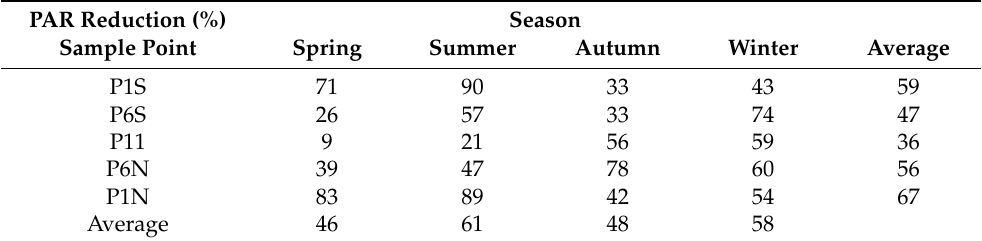
Table 6. PAR reduction (%) compared to open field measurements for spring, summer, autumn, and winter. Sample points between the tree rows are P1S: 1 m and P6S: 6 m from southern row. P1N: 1 m and P6N: 6 m from northern row. P11: 11 m from southern and northern row, respectively. PAR Reduction (%) Season Sample Point Spring Summer Autumn Winter